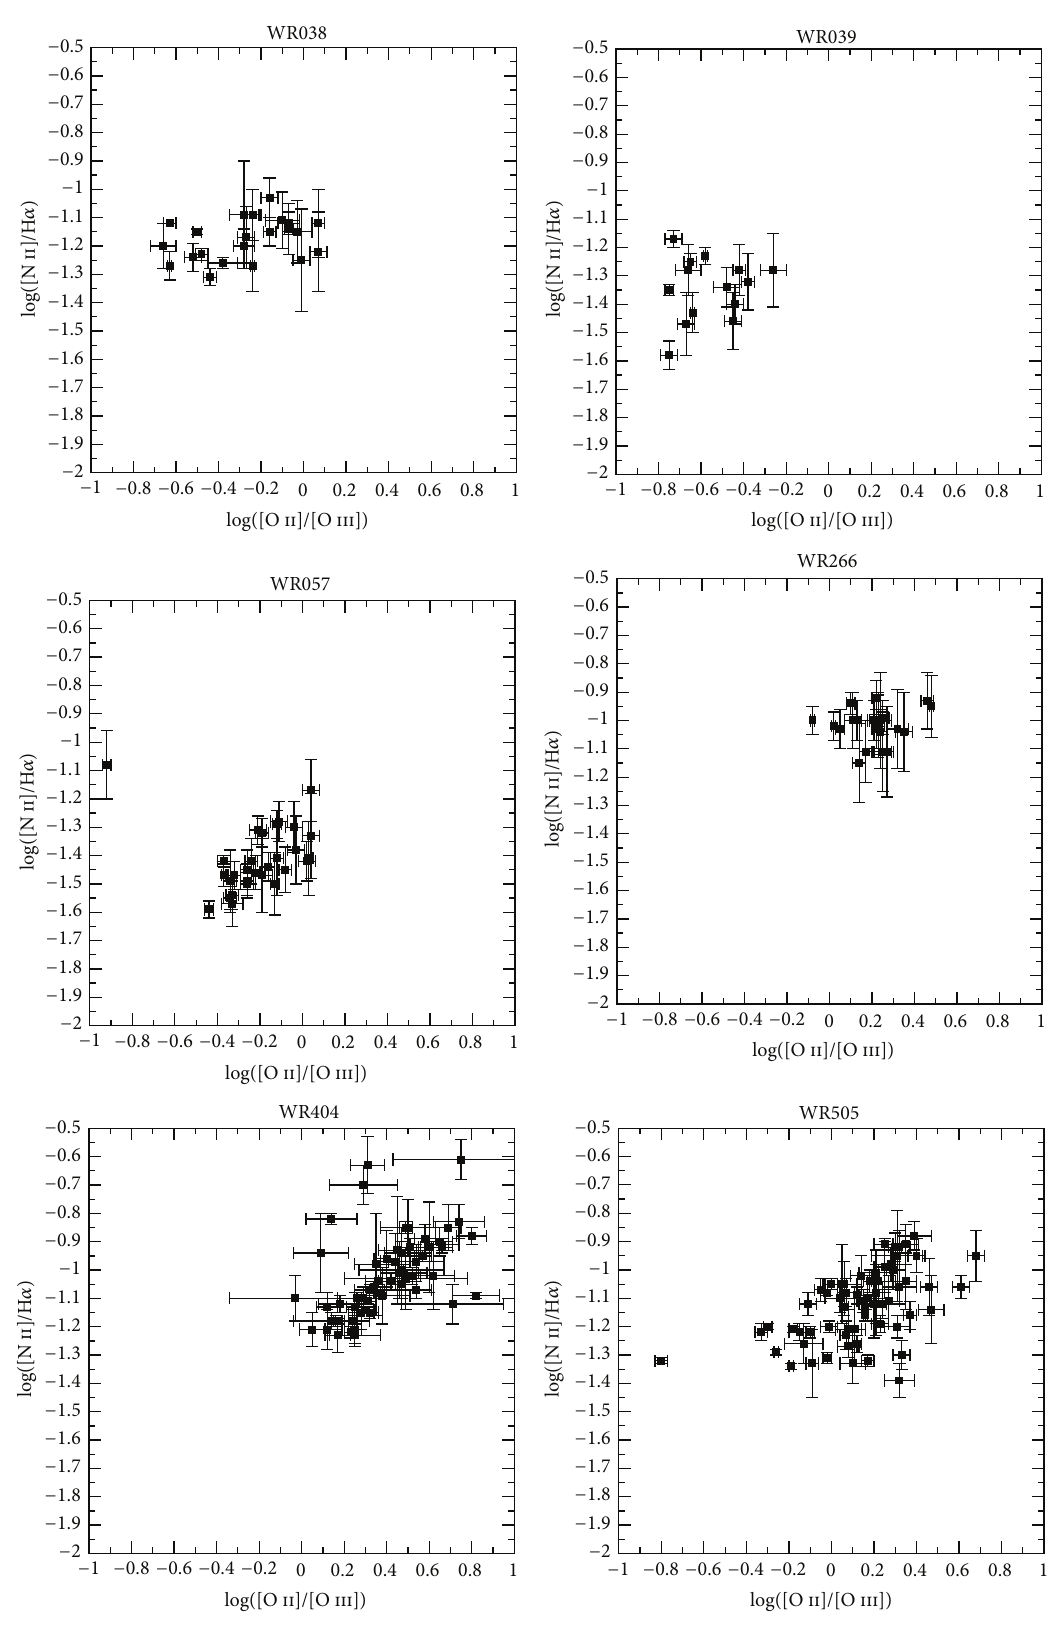
Figure 2: Relation between the [O ii]/[O iii] and [N ii]/H 𝛼 emission line ratios for those spaxels with sufficient S/N in the four involved lines of the six observed